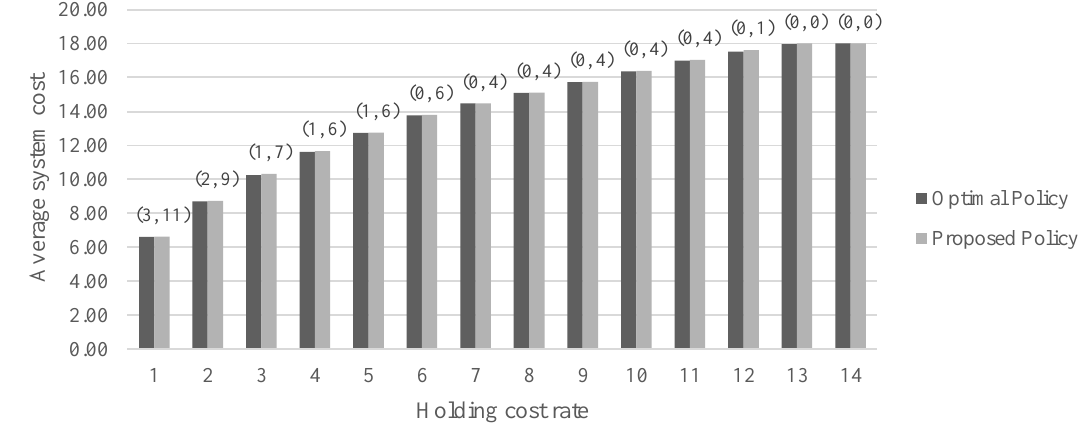
Figure 2. Effects of changes in h on the average cost and (𝐼 ∗ , 𝐼 ∗∗